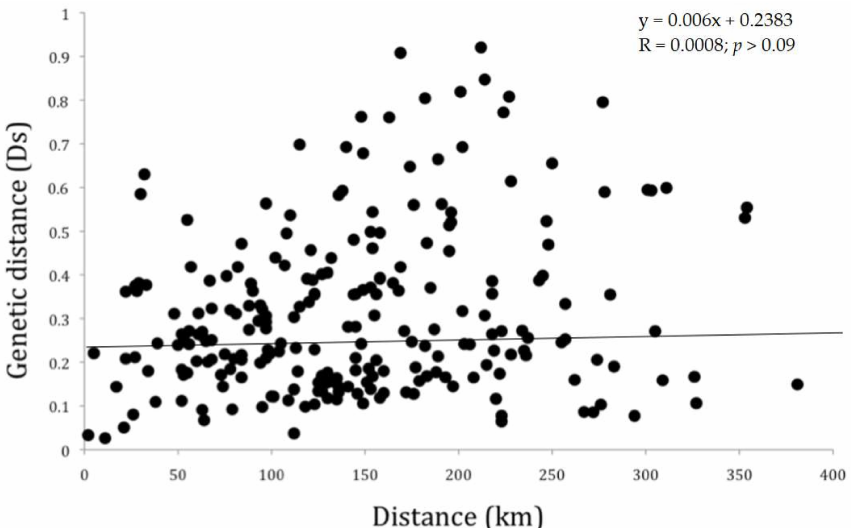
Figure 2. Mantel test based on Ds genetic distance and Euclidean spatial distance (km). There was no relationship between genetic and geographic distance in wild pigs sampled in 24 sites during 2005–2009 in southern Texas,